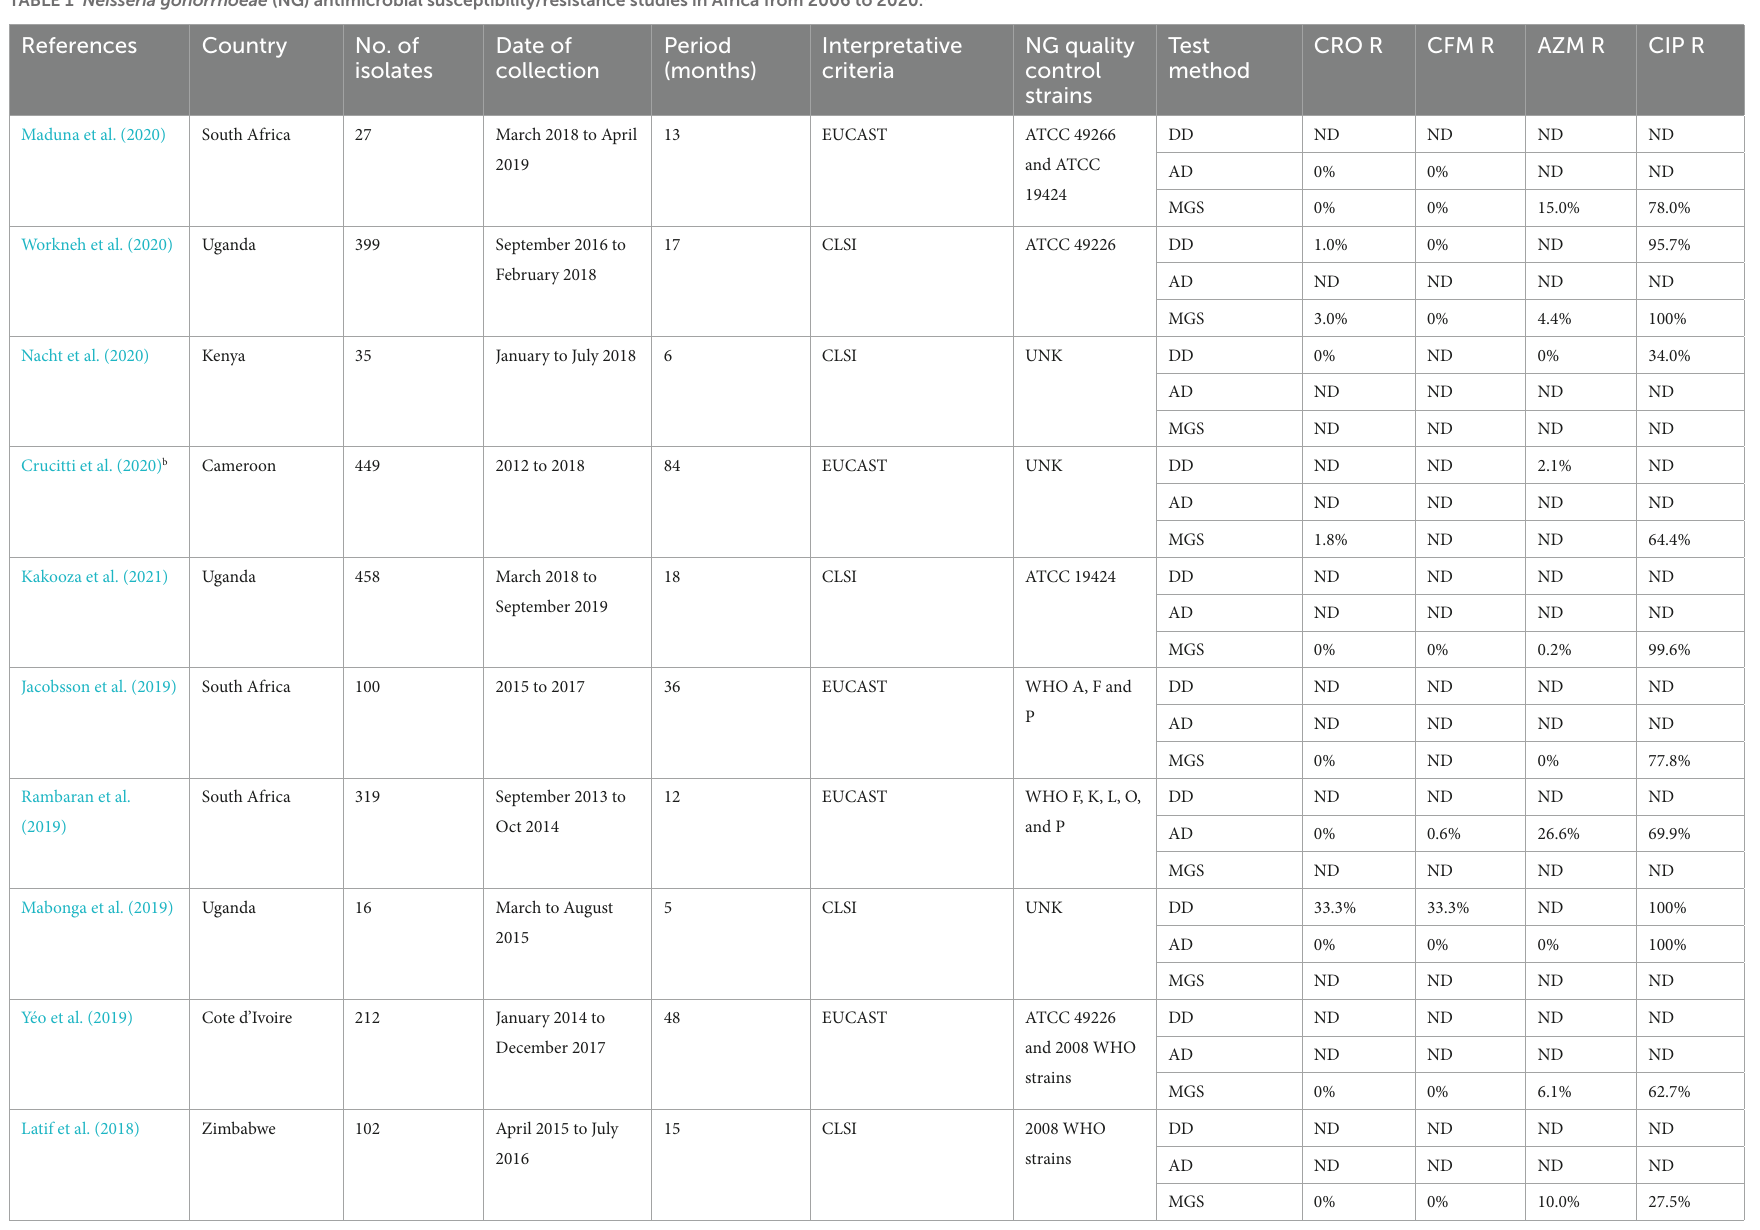
TABLE 1 Neisseria gonorrhoeae (NG) antimicrobial susceptibility/resistance studies in Africa from 2006 to 2020.